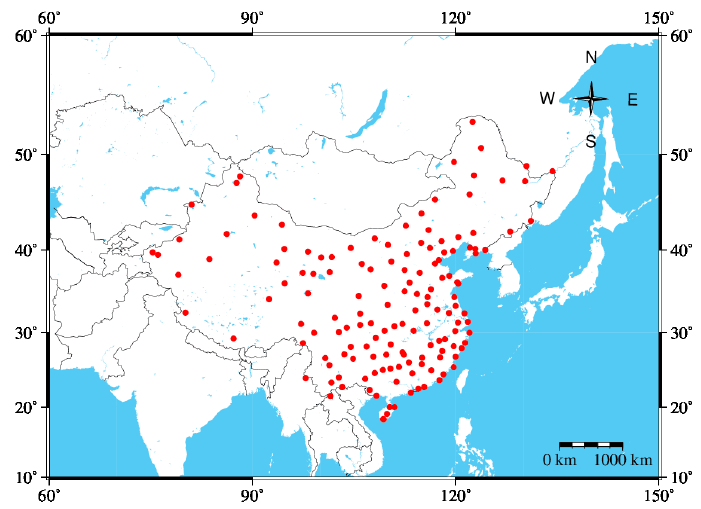
Figure 1. Distribution of NBASS network stations.